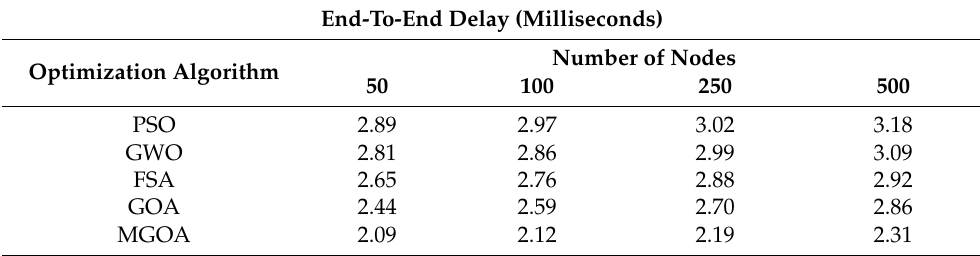
Table 6. Performance analysis of MGOA-WAVLCN in terms of end-to-end